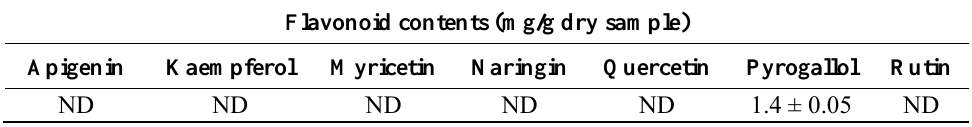
Table 3. Flavonoid compounds in methanolic extract of C. sativus L.